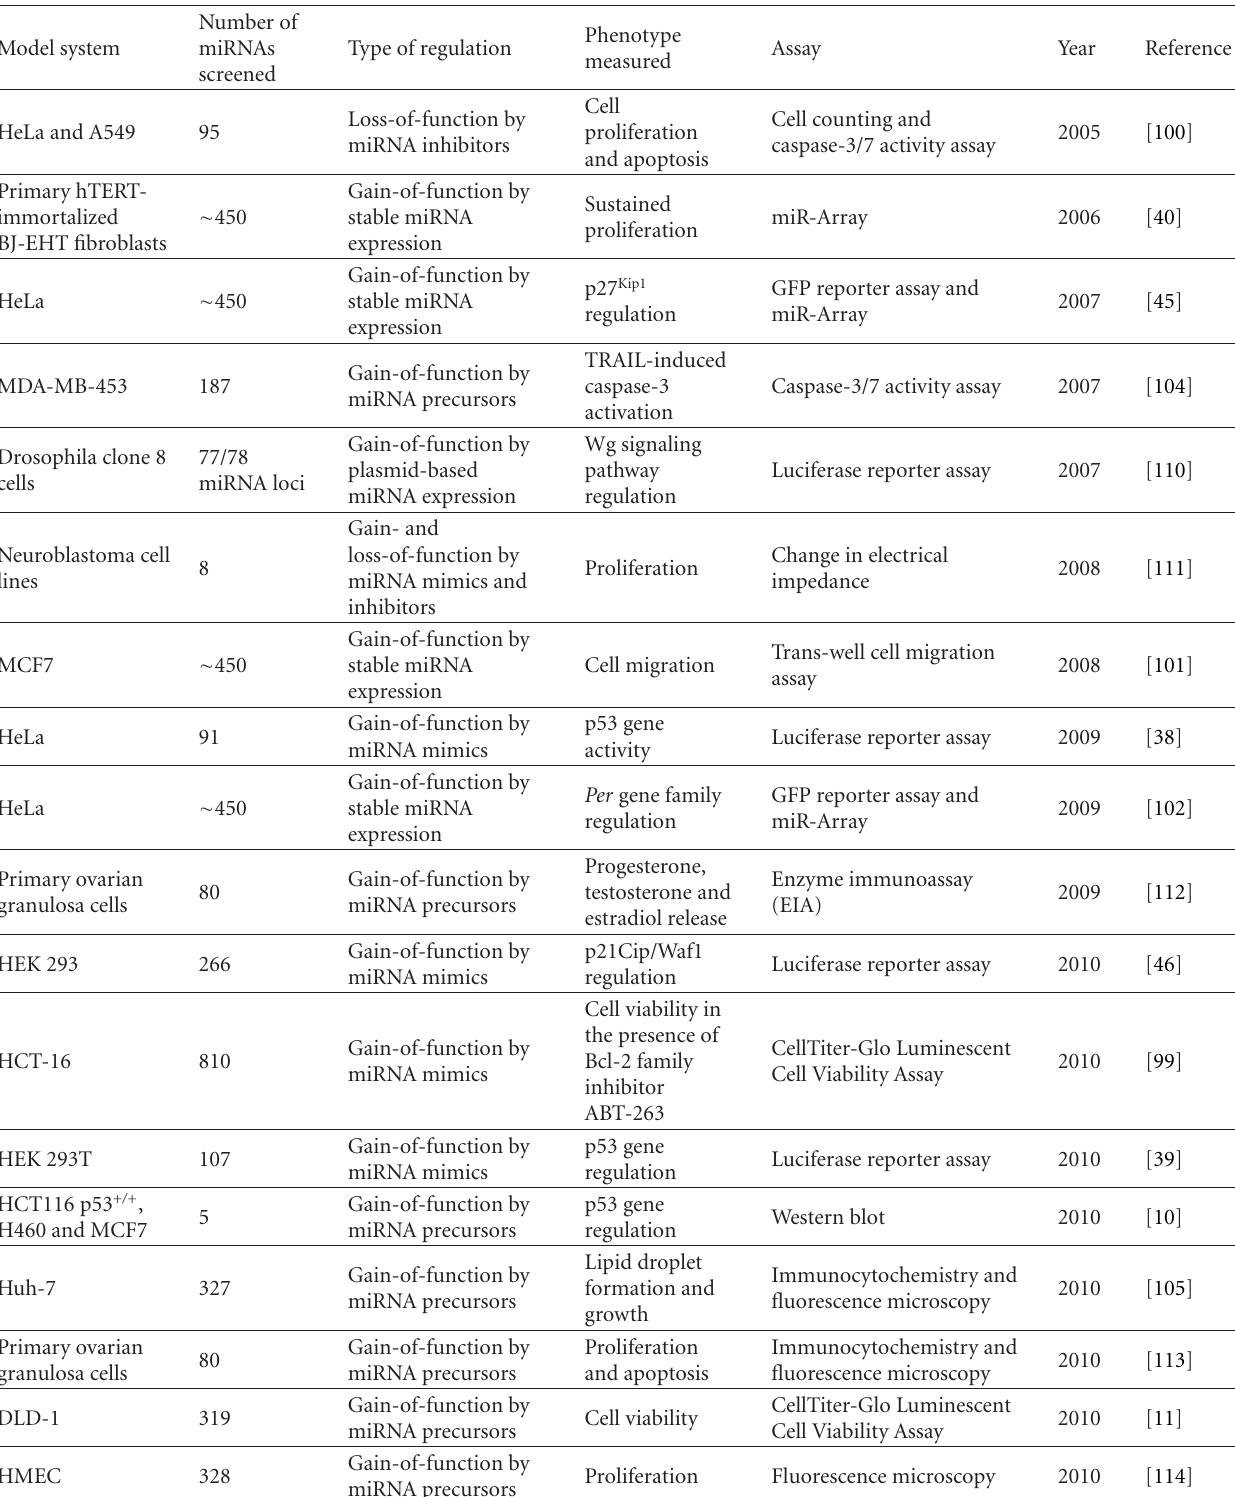
Table 2: miRNA-based functional